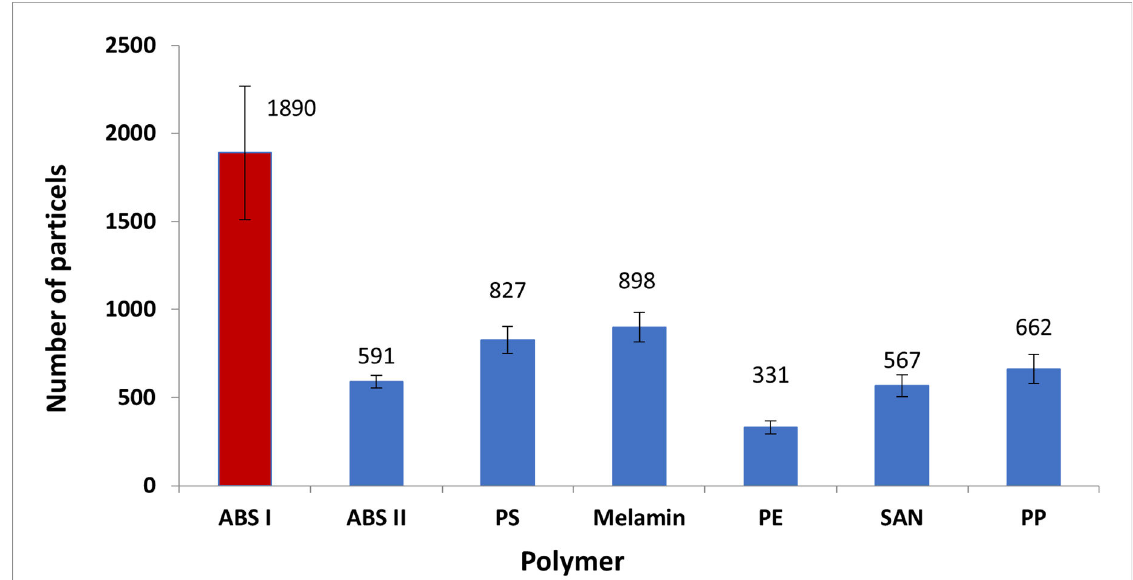
Figure 1. FTIR spectrometer microplastic analysis of the different plastic bowls listed according to the type of material. Red bar = use of water and salt. Blue bar = use of water